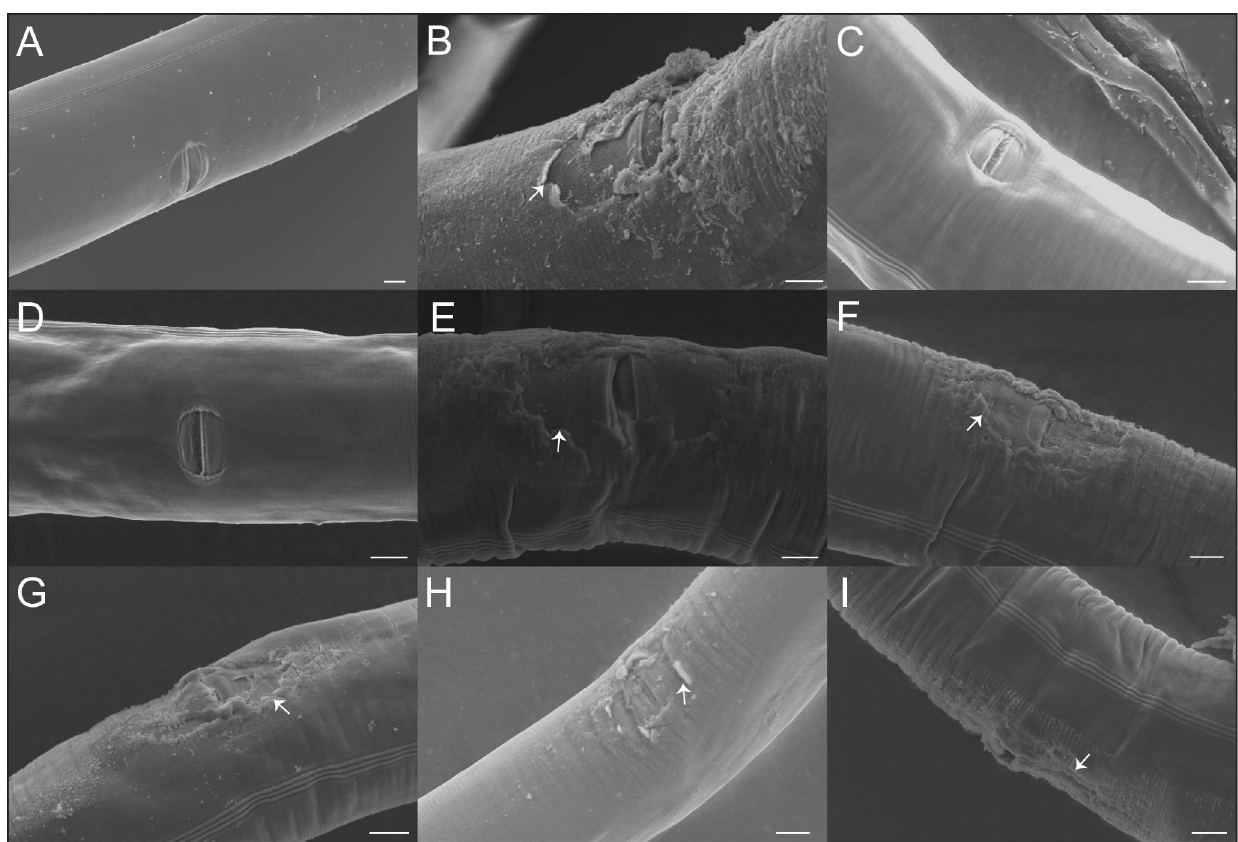
Figure 1. Mating causes vulva cuticle damage in C . elegans hermaphrodites. (A) The vulva of an unmated N2 hermaphrodite. (B) The vulva of a N2 hermaphrodite mated with a male with an N2 background. The arrow denotes where delamination of the cuticle surface near the vulva has occurred. (C–D) Unmated QG2288 hermaphrodites with no apparent physical damage. (E) A rare unmated QG2288 hermaphrodite with damage near the vulva (arrow). (F–I). QG2288 hermaphrodites mated with males of the same strain. Arrows denote the presence of cuticle tearing near the vulva. Scale bars represent ten microns in all panels.